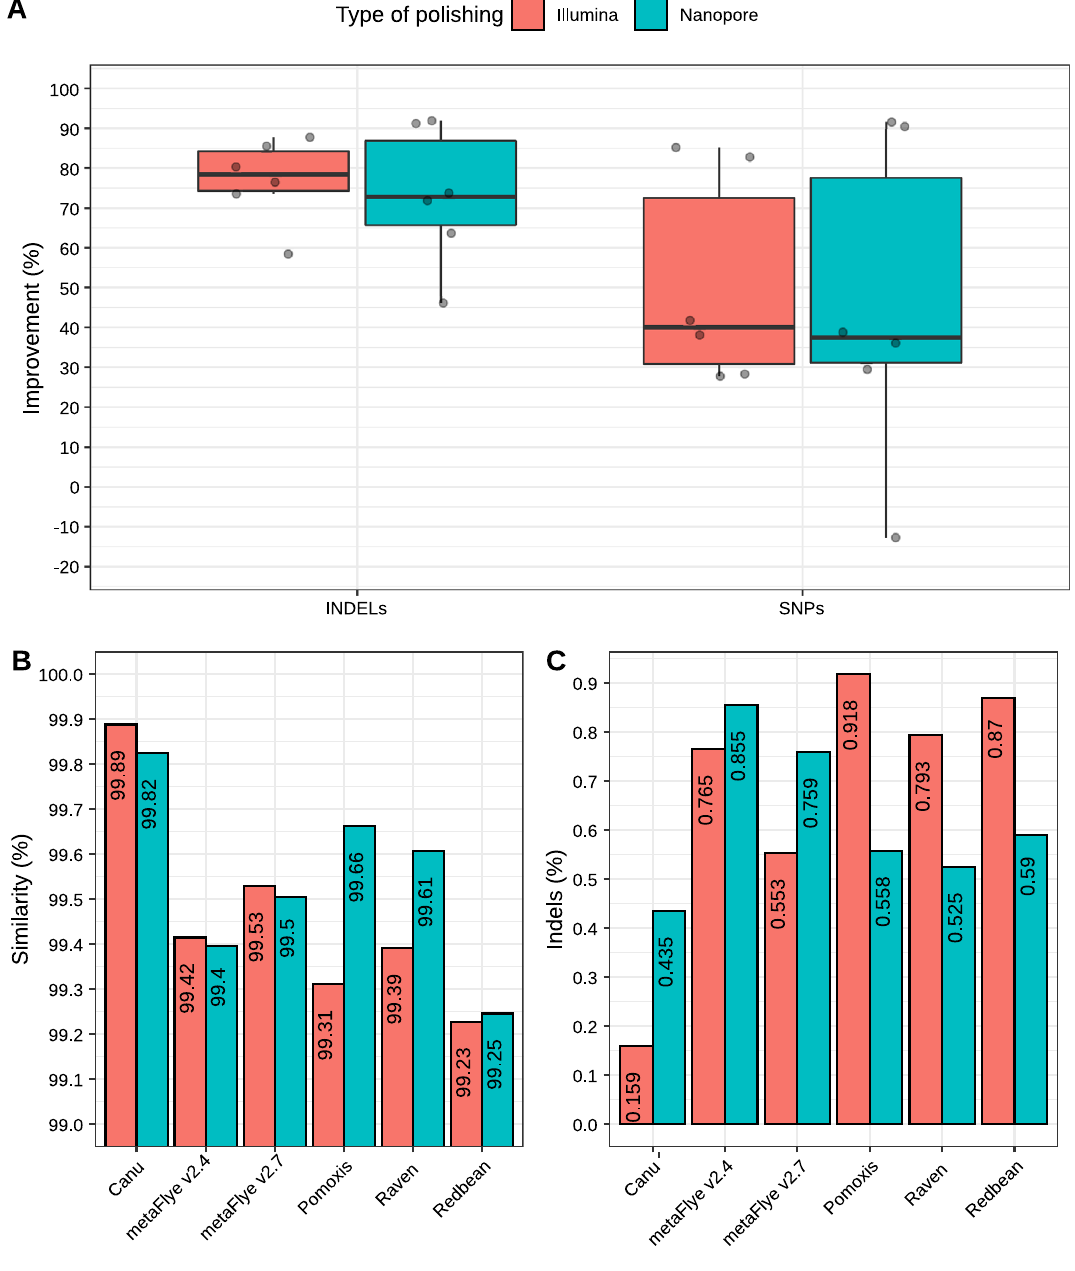
Figure 7. Polishing evaluation. ( A ) Percentage of improvement within the whole metagenome, taking as a reference the number of errors prior to polishing; ( B ) highest similarity percentage achieved by each tool; ( C ) best indel ratio achieved by each tool. Note that a different number of polishing rounds may be needed for achieving the highest similarity and the lowest indel ratio depending on the